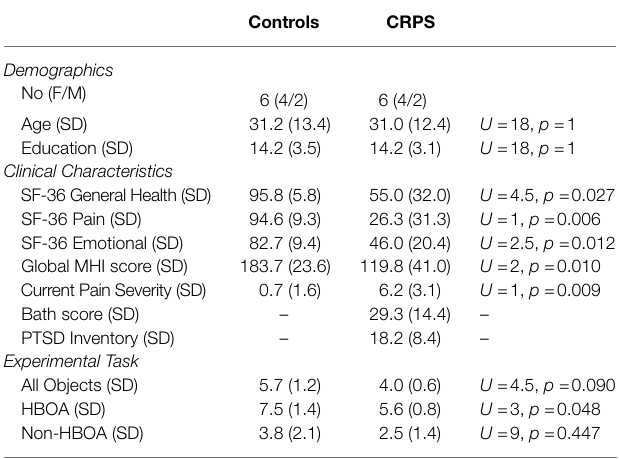
TABLE 2 | Demographic Data, Clinical Characteristics and Experimental Task Results.